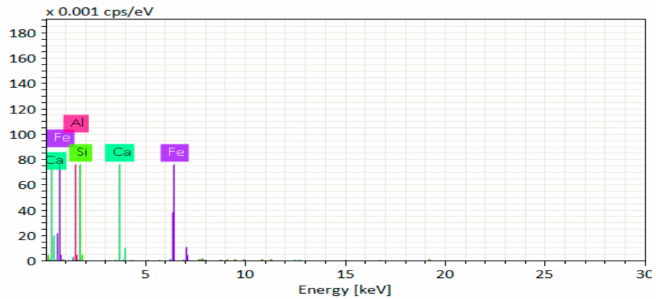
Figure 23. EDS graph of GPC-D0F mix